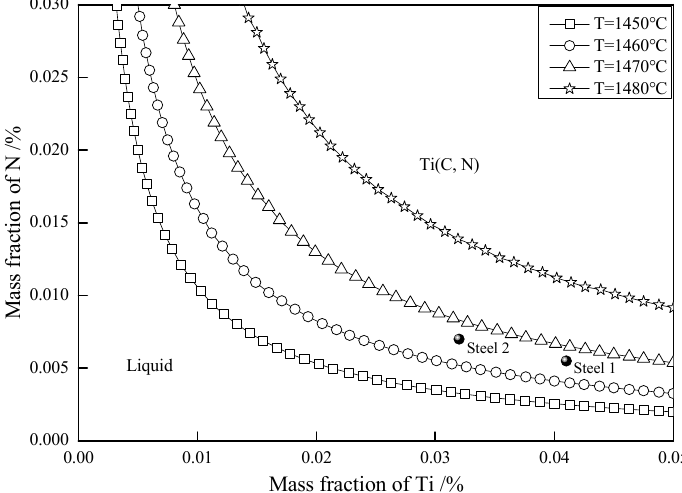
Figure 16. Phase equilibrium between molten steel and Ti(C, N) inclusion.